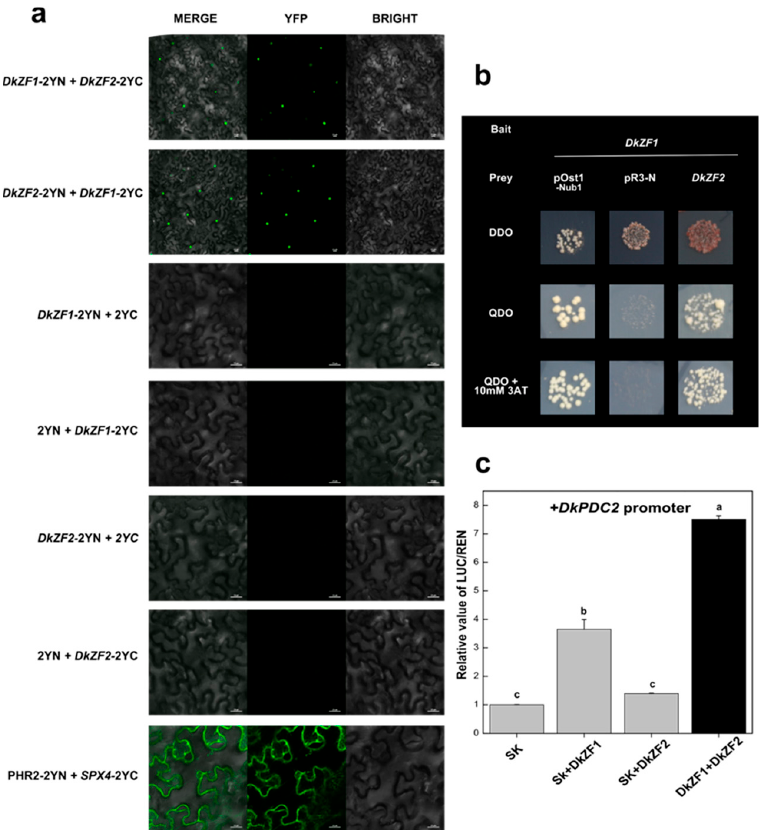
Figure 4. Protein–protein interactions of DkZF1 and DkZF2 and their synergistic relationship with the DkPDC2 promoter. ( a ) bimolecular fluorescence complementation (BiFC) assay of DkZF1 and DkZF2 with all possible combinations while merge and YFP florescence indicate protein–protein interactions. Scale bar 25 µm. ( b ) Y2H assay showed in vivo protein–protein interactions of DkZF1 and DkZF2. The positive control is pOst1–Nub1, while pPR3-N is negative control. ( c ) Synergistic transactivation effect of combination of DkZF1 and DKZF2 genes on the DkPDC2 promoter. Means with different letters had significant differences ( p < 0.05).